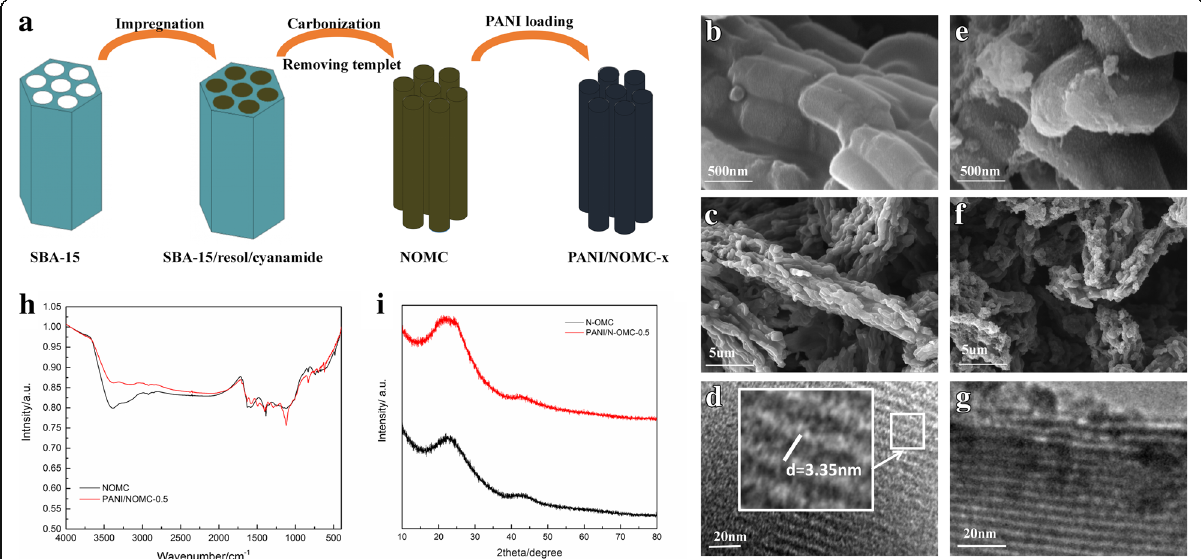
Fig. 1 Scheme for the fabrication of PANI/NOMC- x ( a ). SEM images of NOMC ( b , c ) and PANI/NOMC-0.5 ( e , f ). TEM images of NOMC ( d ) and PANI/NOMC-0.5 ( g ). FT-IR spectra ( h ) and XRD patterns ( i ) of NOMC and